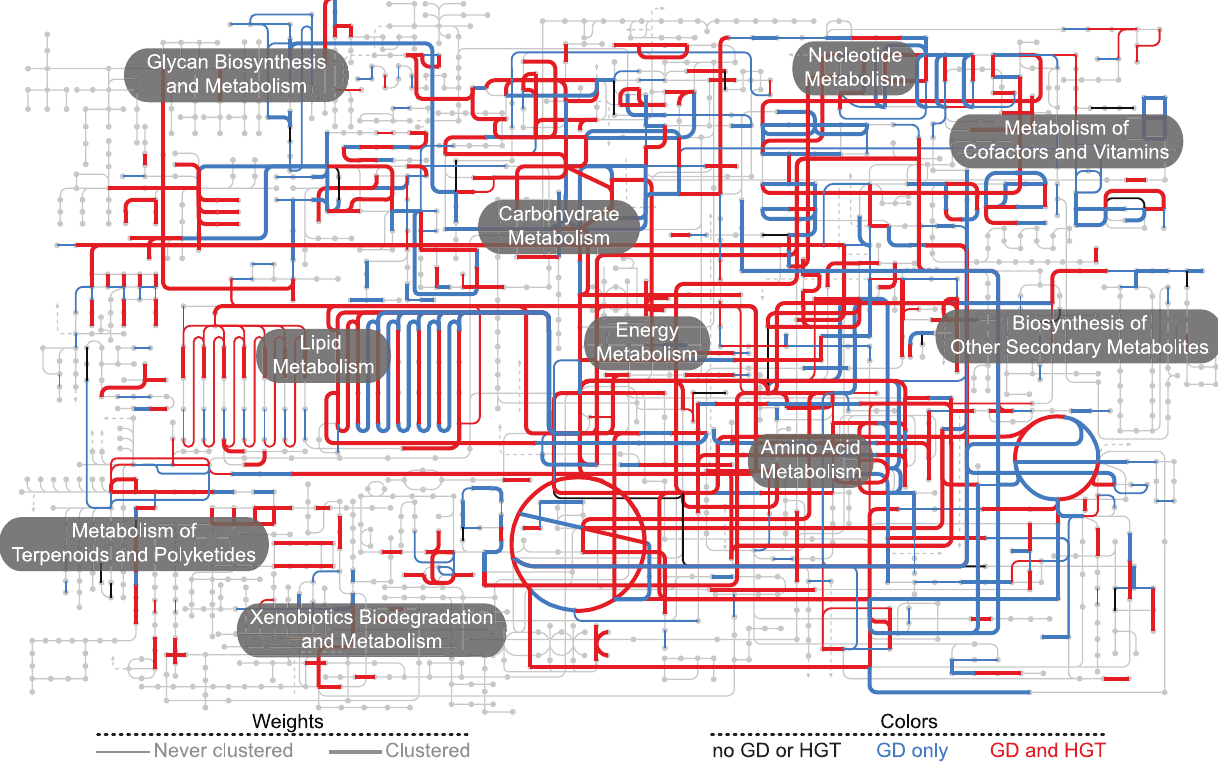
Figure 5. The fungal metabolic network of interactions between gene clustering and two major sources of gene innovation (GD and HGT). Nodes of the metabolic network correspond to KEGG compounds. Thick edges of the metabolic network correspond to EC numbers from clustered ECgenes in one or more fungal species, whereas thin edges to EC numbers whose genes show no history of gene clustering. Colored edges correspond to EC numbers whose ECgenes have undergone HGT and GD (red), GD (blue), or show no history of GD or HGT (black). Note that none of the EC numbers in our dataset were affected by HGT alone. Pathway map created using iPATH2.0 [95].